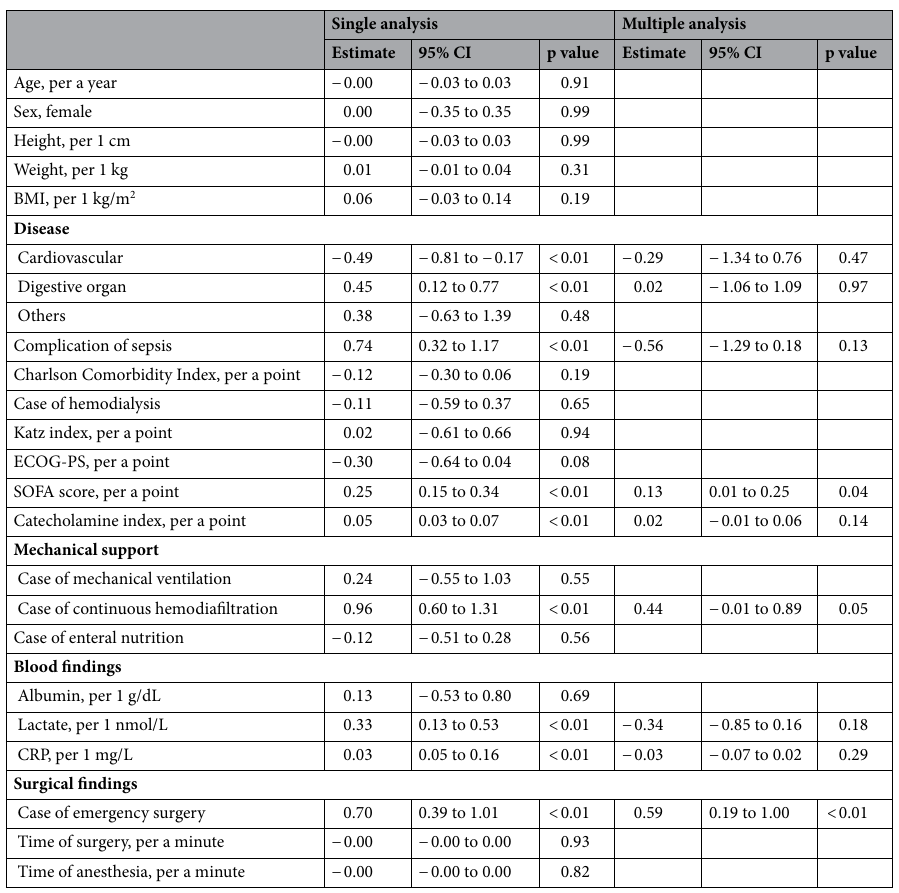
Table 3. Association to sedation period by single and multiple liner regression in surgery cases. BMI body mass index, ECOG-PS the Eastern Cooperative Oncology Group Performance Status, SOFA sequential organ failure assessment, CRP C-reaction